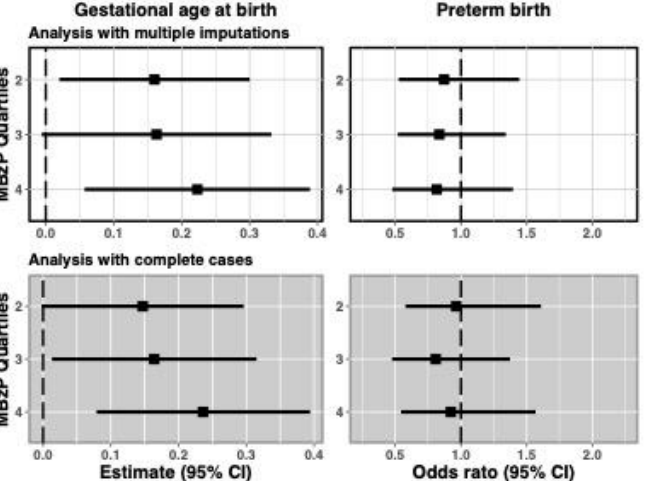
Appendix Figure A3 : Estimated association between MBzP quartiles in the 2nd visit and